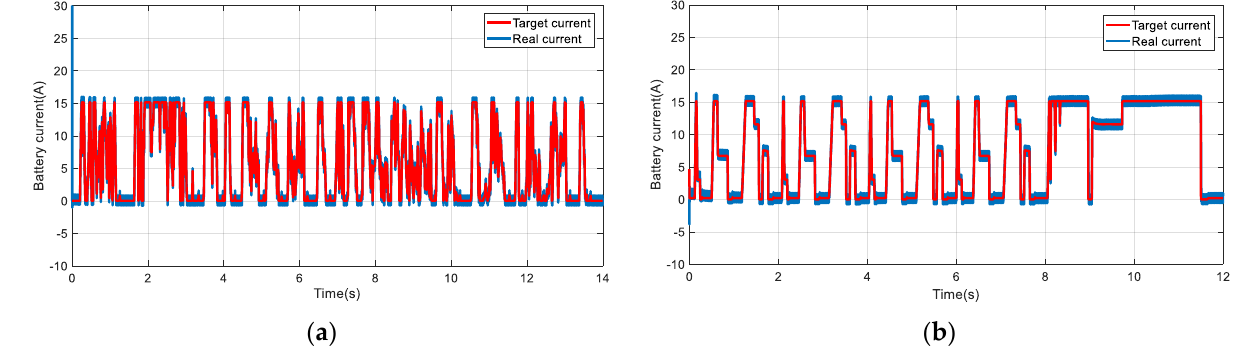
Figure 11. The tracking curves of the battery current: ( a ) UDDS cycle; ( b ) NEDC cycle.